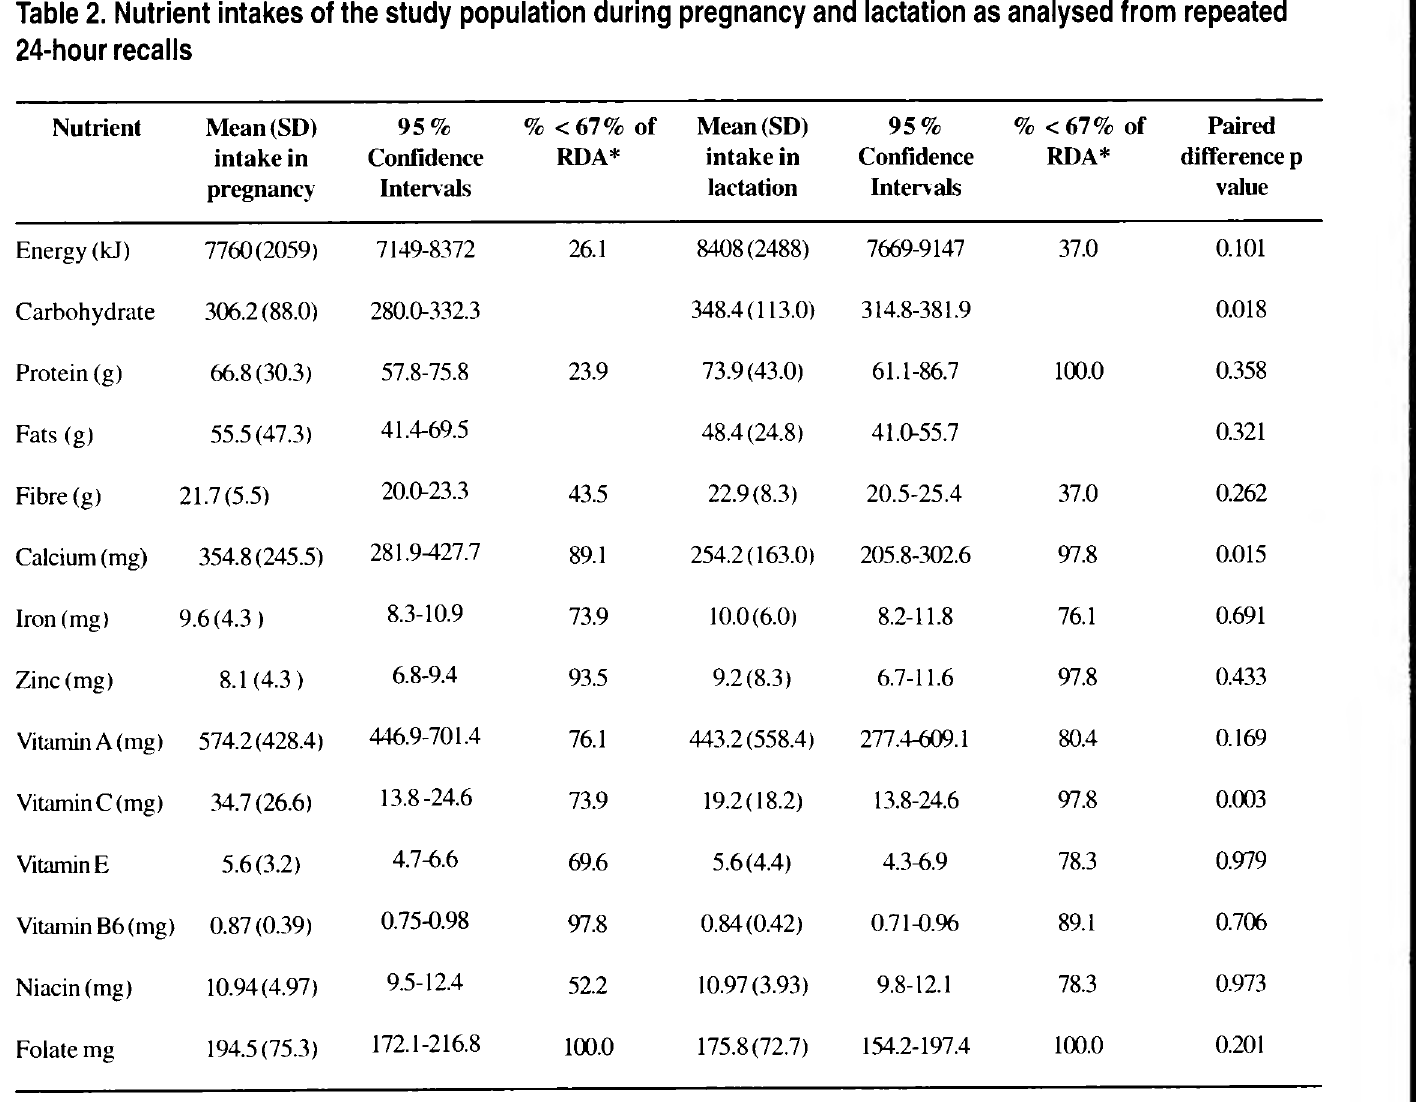
Table 2. Nutrient intakes of the study population during pregnancy and lactation as analysed from repeated 24-hour